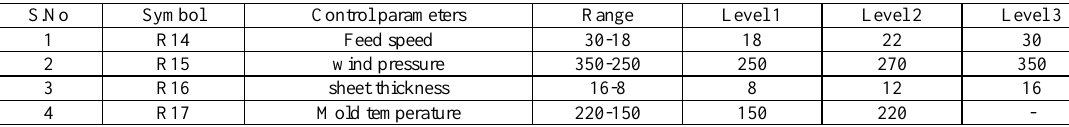
Table 1. Control parameters in the domain